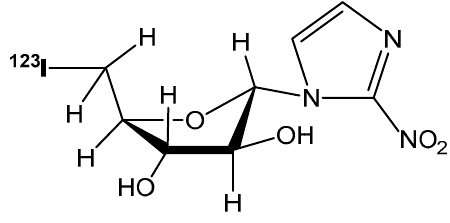
Figure 1. Chemical structure of 1- α - D -(5-deoxy-5-[ `123 I]iodoarabinofuranosyl)-2-nitroimidazole ([ 123 I]iodoazomycin arabinoside; [ 123